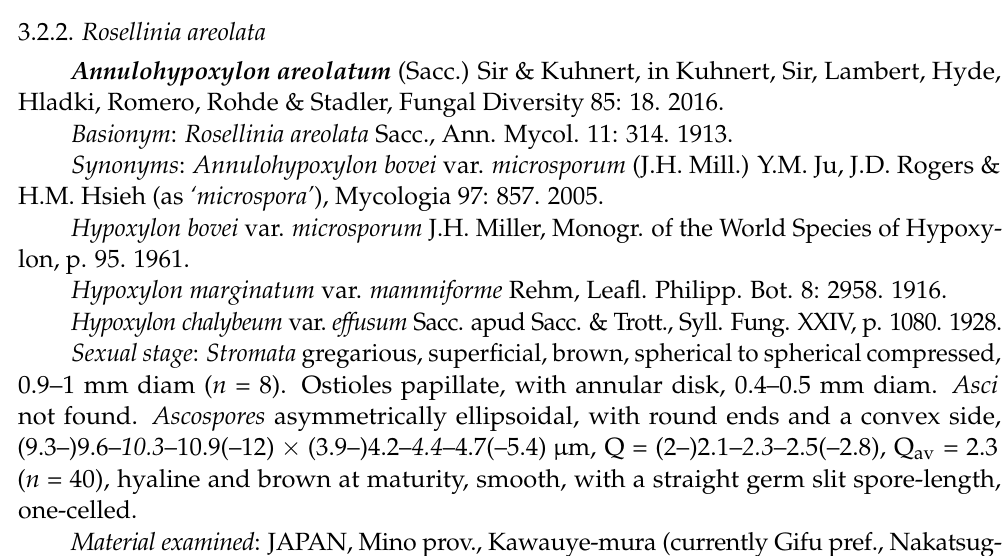
Figure 4 . Rosellinia ambigua . ( a ) Original fungarium specimen. ( b ) Perithecia on natural substrate. ( c ) Ascus with ascospores. ( d ) Ascospores showing germ slit (white asterisk). Scale bars: ( b ) = 100 µ m; ( c ) = 10 μ m; ( d ) = 5 μ m.